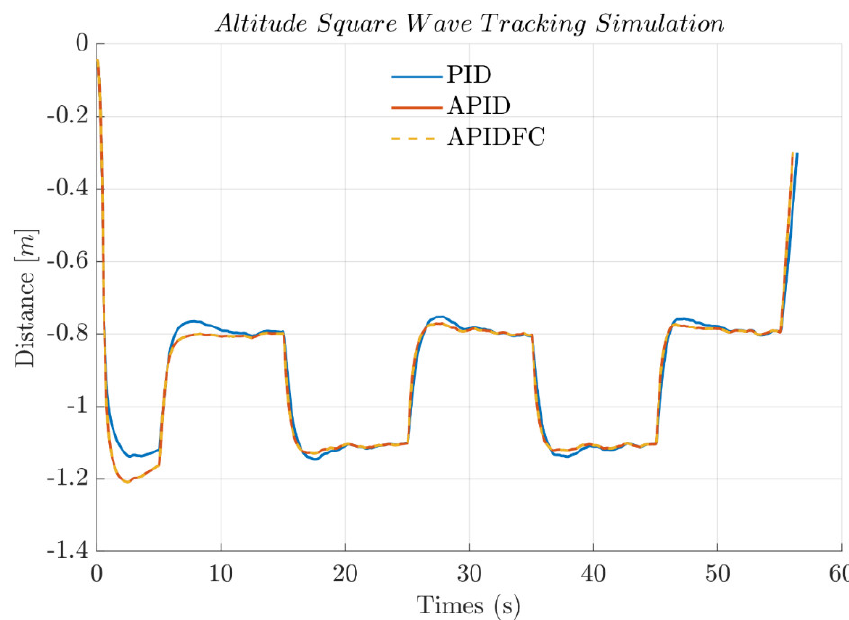
Figure 9. Square wave tracking in the simulation.